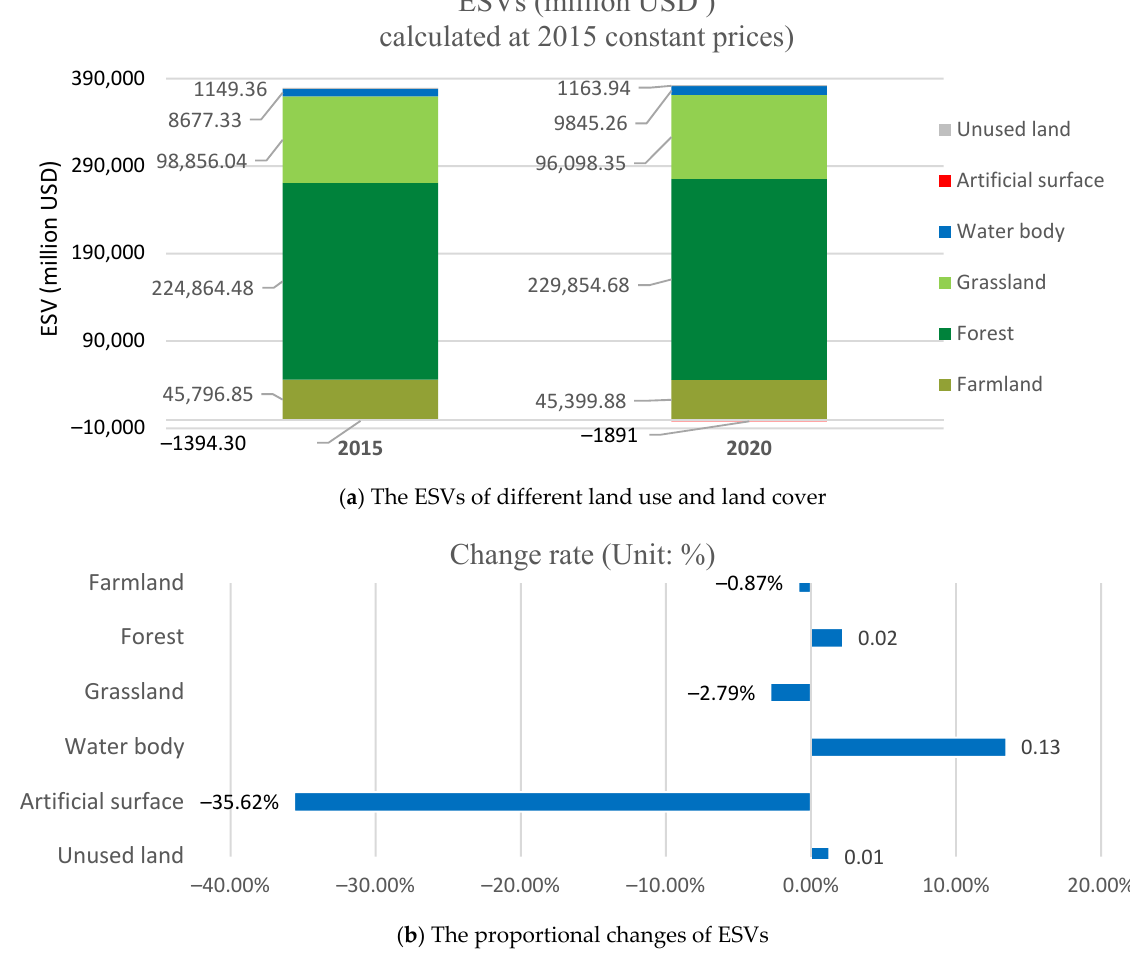
Figure 6. The Variations of ESVs in land use and cover in Sichuan province during 2015–2020.